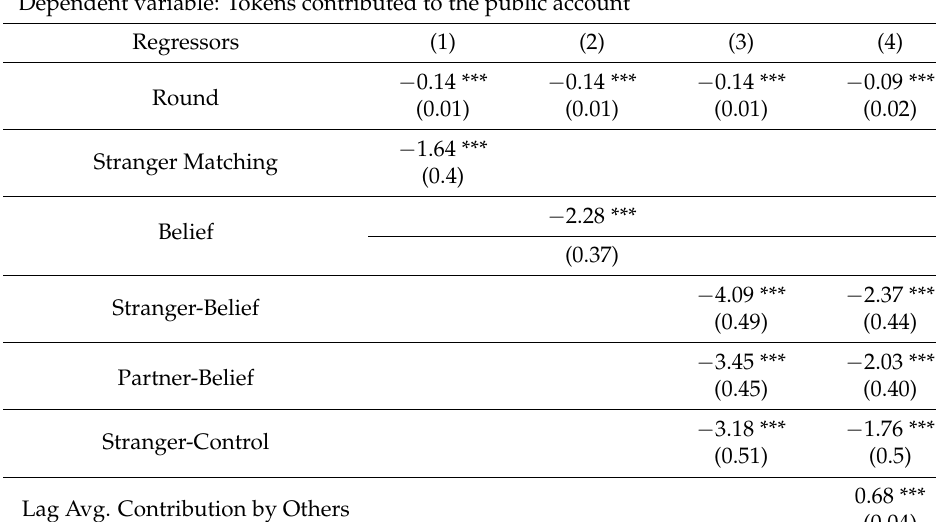
Table 3. Random effects Tobit regressions for